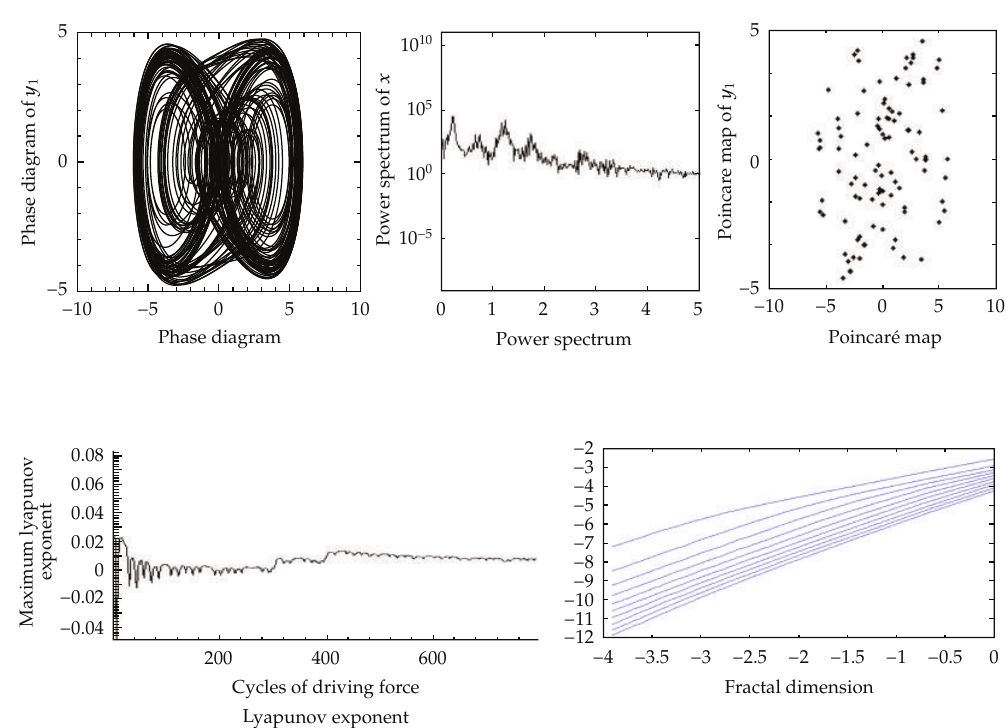
Figure 11: Simulation results obtained for gear-bearing system with s (cid:9) 1 . 2 for y 1 (cid:6) l ∗ (cid:9) 0 . 3 (cid:7) .